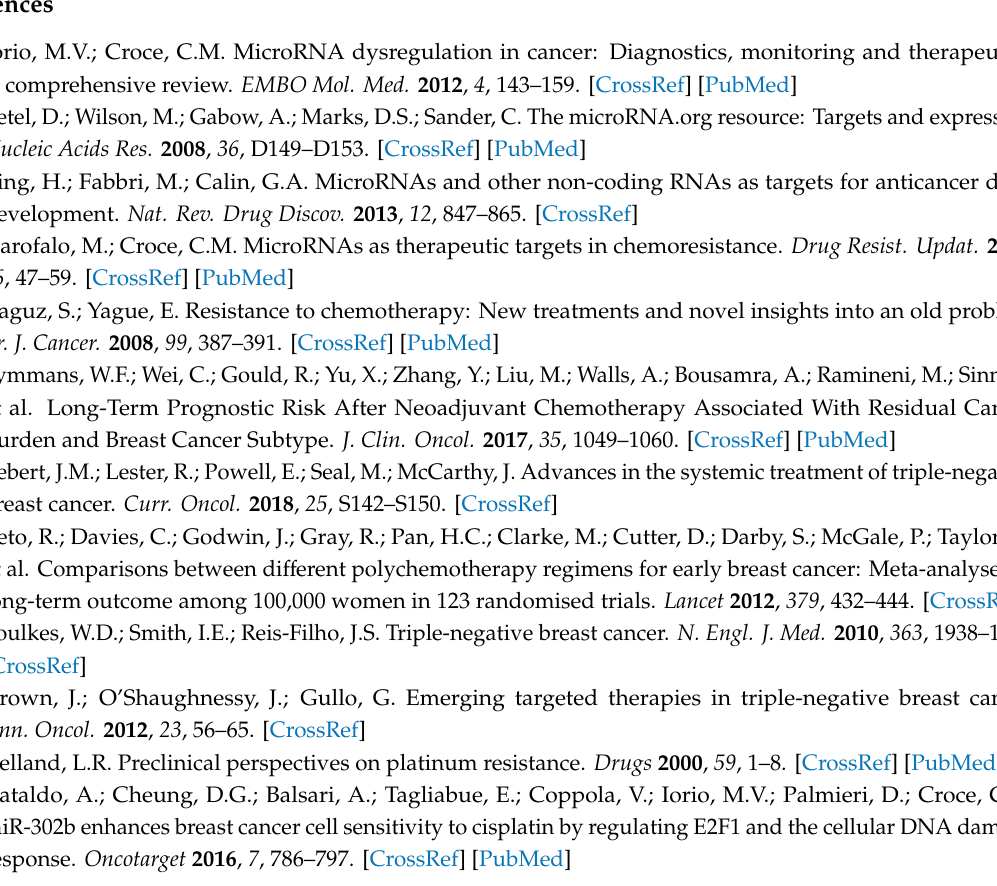
Figure S1. Relative miRNA-302b levels in the four in vivo groups. Data are presented as mean and SD of all tumors from each mice group. Figure S2. Western Blot analysis of Integrin Subunit Alpha 6 (ITGA6) protein expression in mice tumors treated with miR-302b mimic alone and cel-miR-67 alone. Upper figure shows specific ITGA6 bands and vinculin bands as housekeeping; lower histogram represents ITGA6 densitometric quantification. Figure S3. BT549 cell count after small interfering-ITGA6 (si-ITGA6) transfection and cisplatin treatment compared with their negative controls. Data are representative of three independent experiments performed at least by triplicate (* p ≤ 0.05 Student’s t test). Figure S4. Veen diagram showing the overlap of enriched Transcription Factors (TFs) whose binding sites are overrepresented in the promoter of the di ff erentially expressed genes in in vivo assay (miR-302b + cisplatin versus cel-miR-67 negative control + cisplatin). Identification of enriched transcription factors using oPOSSUM and PASTAA algorithms. Figure S5. Densitometric protein quantifications of figures 4 and 5, performed with QuantiyOne tool. Figure S6. Correlation matrix of Yin Yang 1 (YY1) and human TFs in TNBC cases of ITAL-MEX and TCGA cohorts computed by Spearman correlation. Purple areas indicate strong positive correlation. Only genes with a significant correlation (BH adjusted p < 0.05) were colored. Figure S7. Normalized expression profiles of E2F / ITAG6 / YY1 axis on TCGA and METABRIC cohorts. Table S1: Gene expresion profiles of in-vivo assay evalauted by microarray analysis. Table S2: Summary of the TFs in silico analysis including oPOSSUM, PASTAA and miRwalk results. Table S3: Summary of in-silico JASPAR analysis of the selected